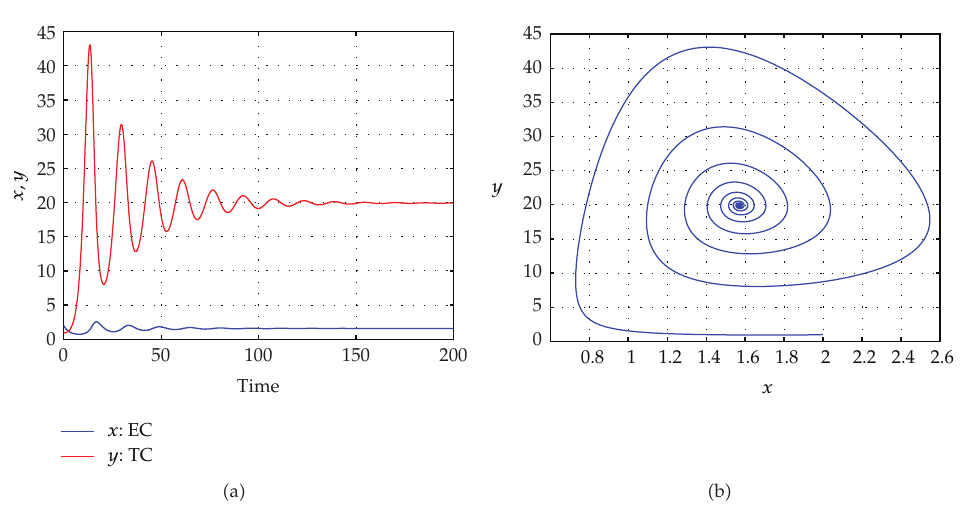
Figure 2: Solution of the DDEs (cid:4) 2.7 (cid:5) when ω (cid:8) 0 . 01184, μ (cid:8) 0 . 3747, s (cid:8) 0 . 2181, r (cid:8) 1 . 636, b (cid:8) 0 . 002 and τ (cid:8) 0 . 8. This shows a stable endemic equilibrium.